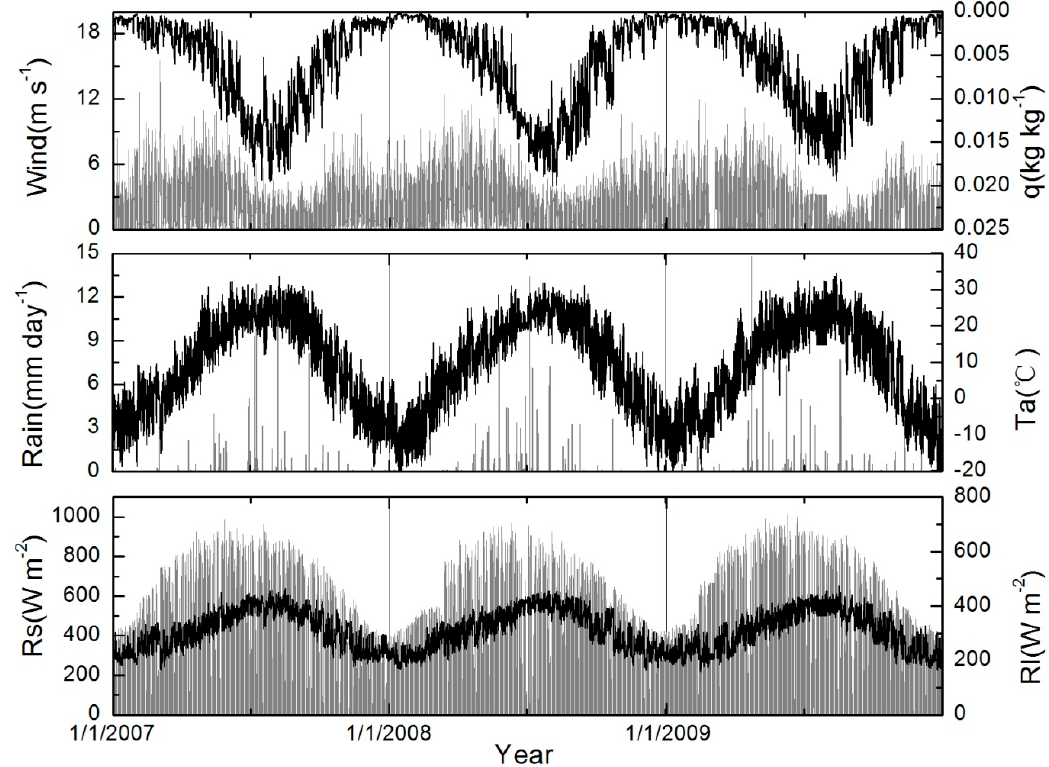
Figure 1. Half-hourly wind speed (Wind, gray) and specific humidity (q, black), air temperature (Ta, black), short wave radiation (Rs, gray) and long wave radiation (Rl, black) and daily precipitation (Rain, gray) at Jinzhou in Northeast China during 2007–2009.